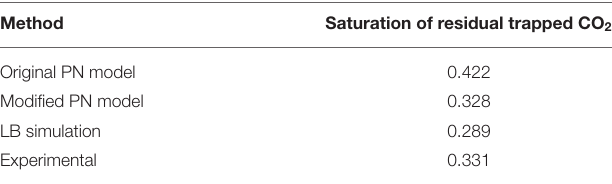
TABLE 5 | Comparison of the original and modified pore-network flow models on the Berea sandstone sample based on predicted saturation of residual trapping of CO 2 after a drainage-imbibition